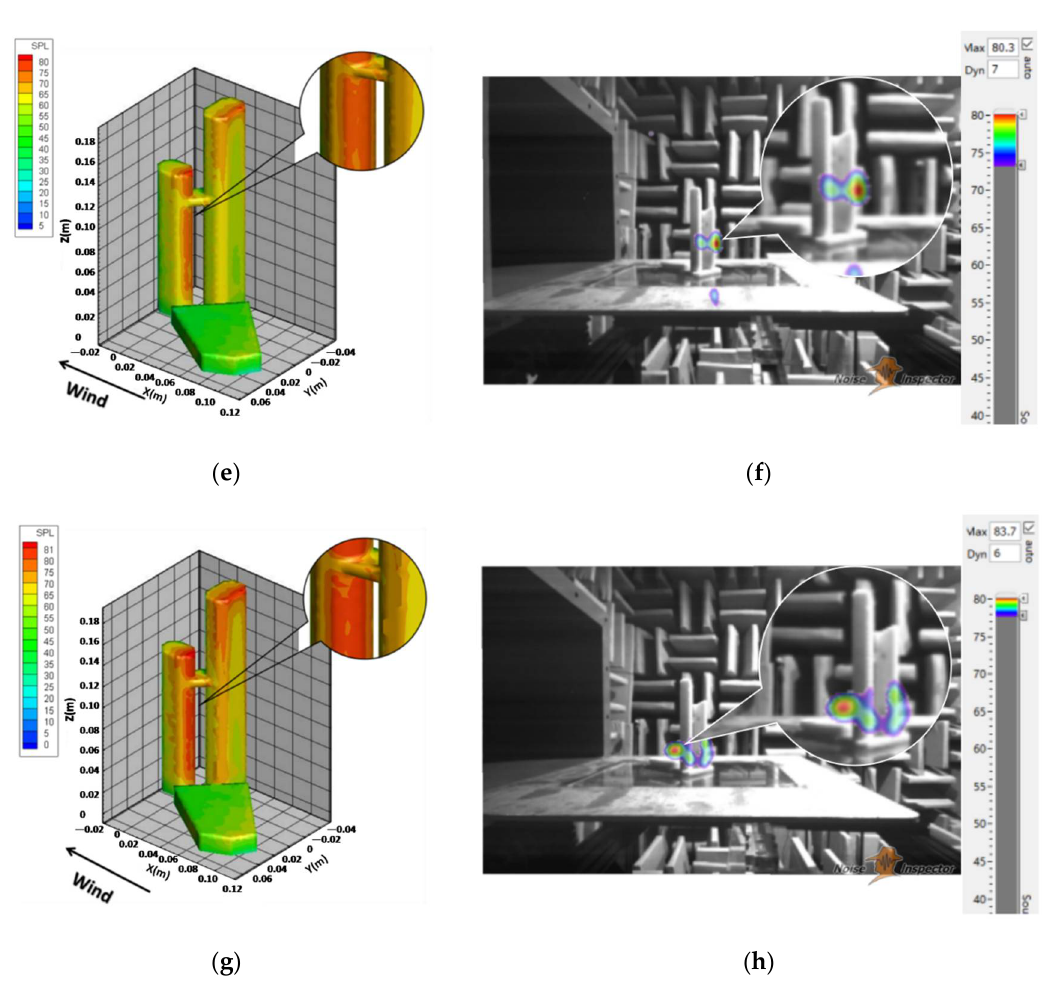
Figure 10. Comparison of experimental and simulated sound source localization at the wind angle of 180°. ( a ) 25 m/s numerical simulation; ( b ) 25 m/s wind tunnel experiment; ( c ) 30 m/s numerical simulation; ( d ) 30 m/s wind tunnel experiment; ( e ) 35 m/s numerical simulation; ( f ) 35 m/s wind tunnel experiment; ( g ) 40 m/s numerical simulation; ( h ) 40 m/s wind tunnel experiment.